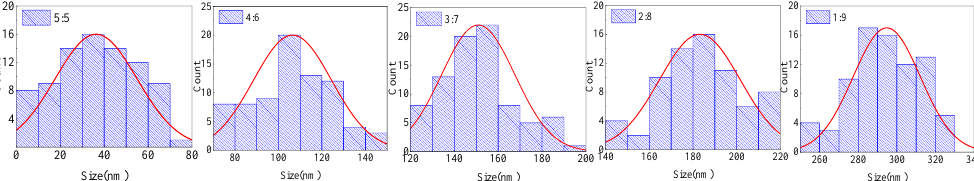
Figure 4. Particle size distribution diagram. The volume ratios of toluene and n-octane in the inks are 5:5, 4:6, 3:7, 2:8, and 1:9. Table 4. Ink surface tension, particle size, and “ coffee ring ” width.